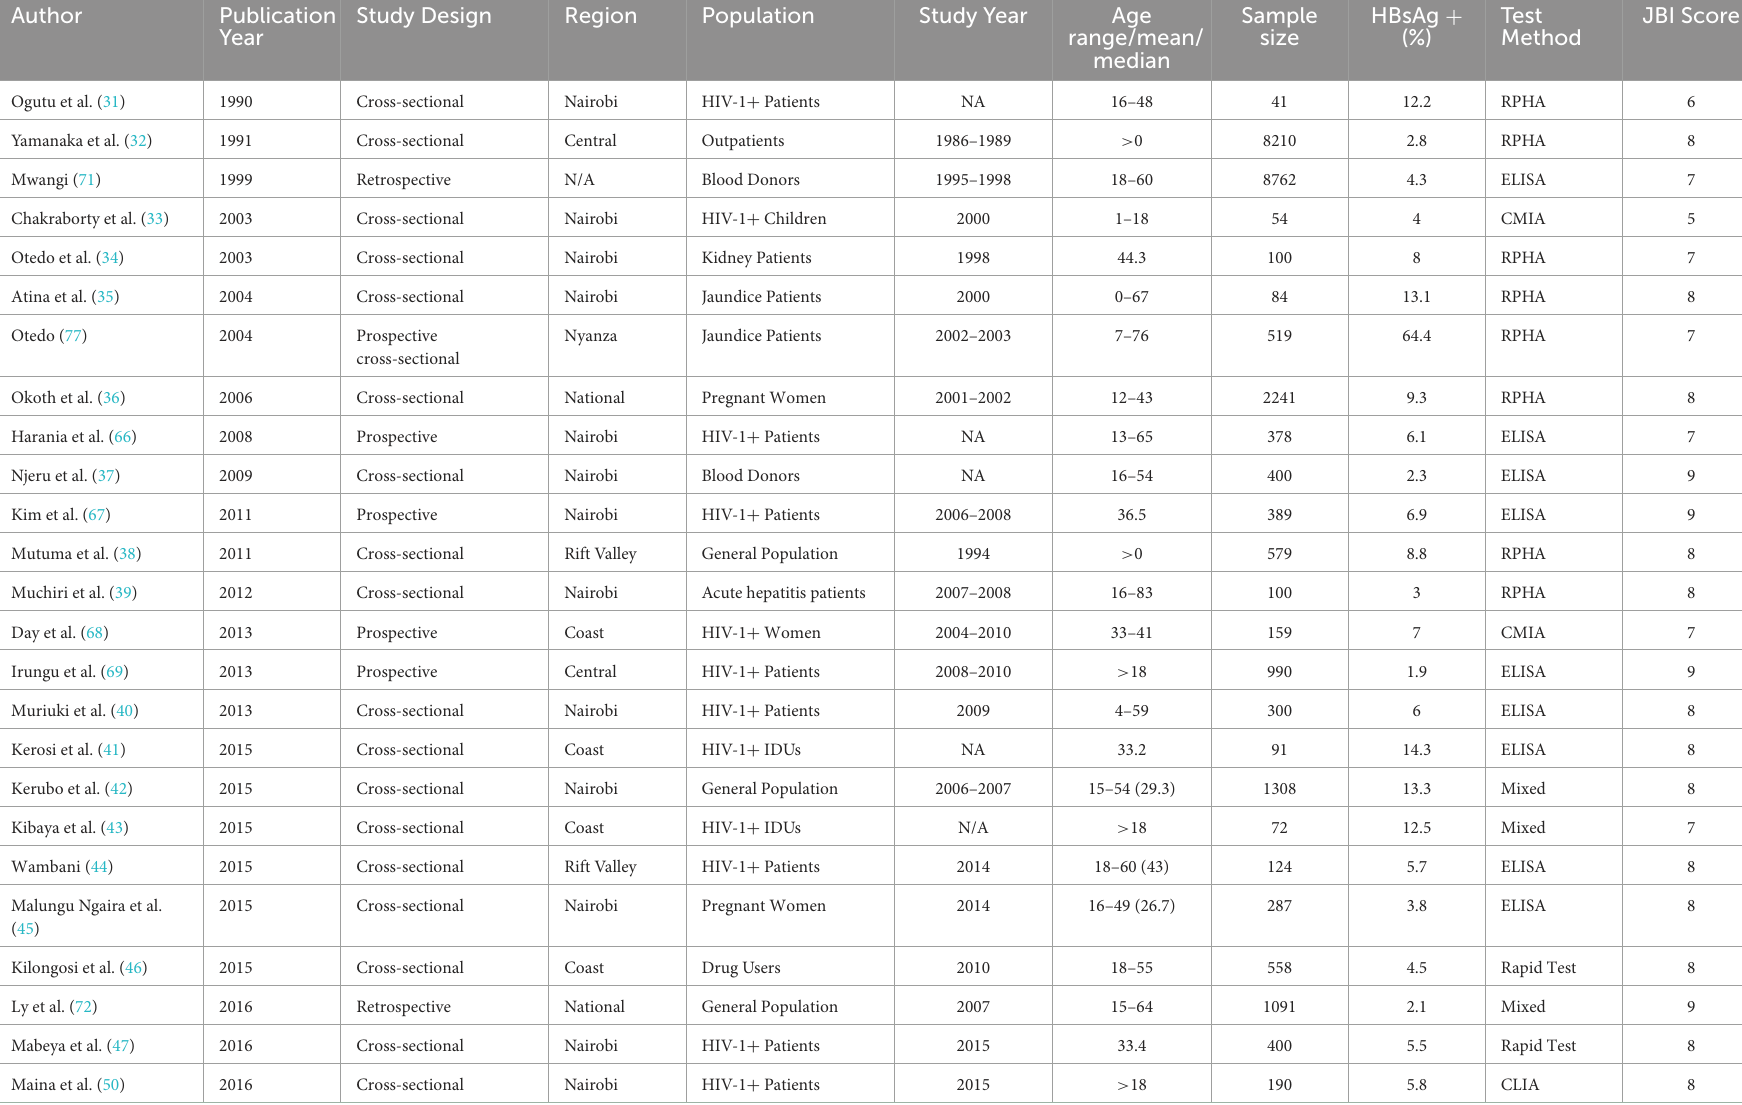
TABLE 1 Characteristic of studies included in the systematic review and meta-analysis of HBV in